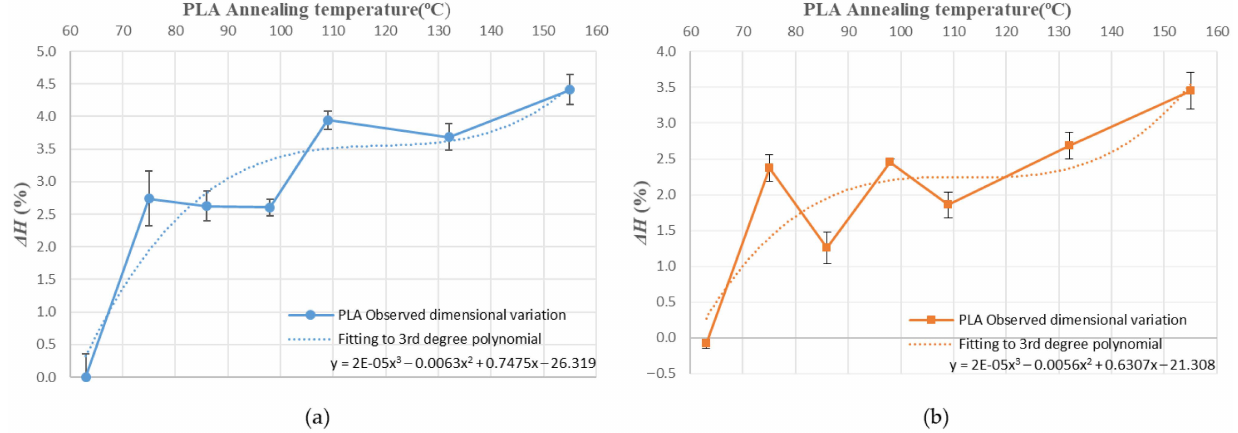
Figure 15. PLA height variation vs. annealing temperature third-degree polynomial approximation: ( a ) without mould; ( b ) with